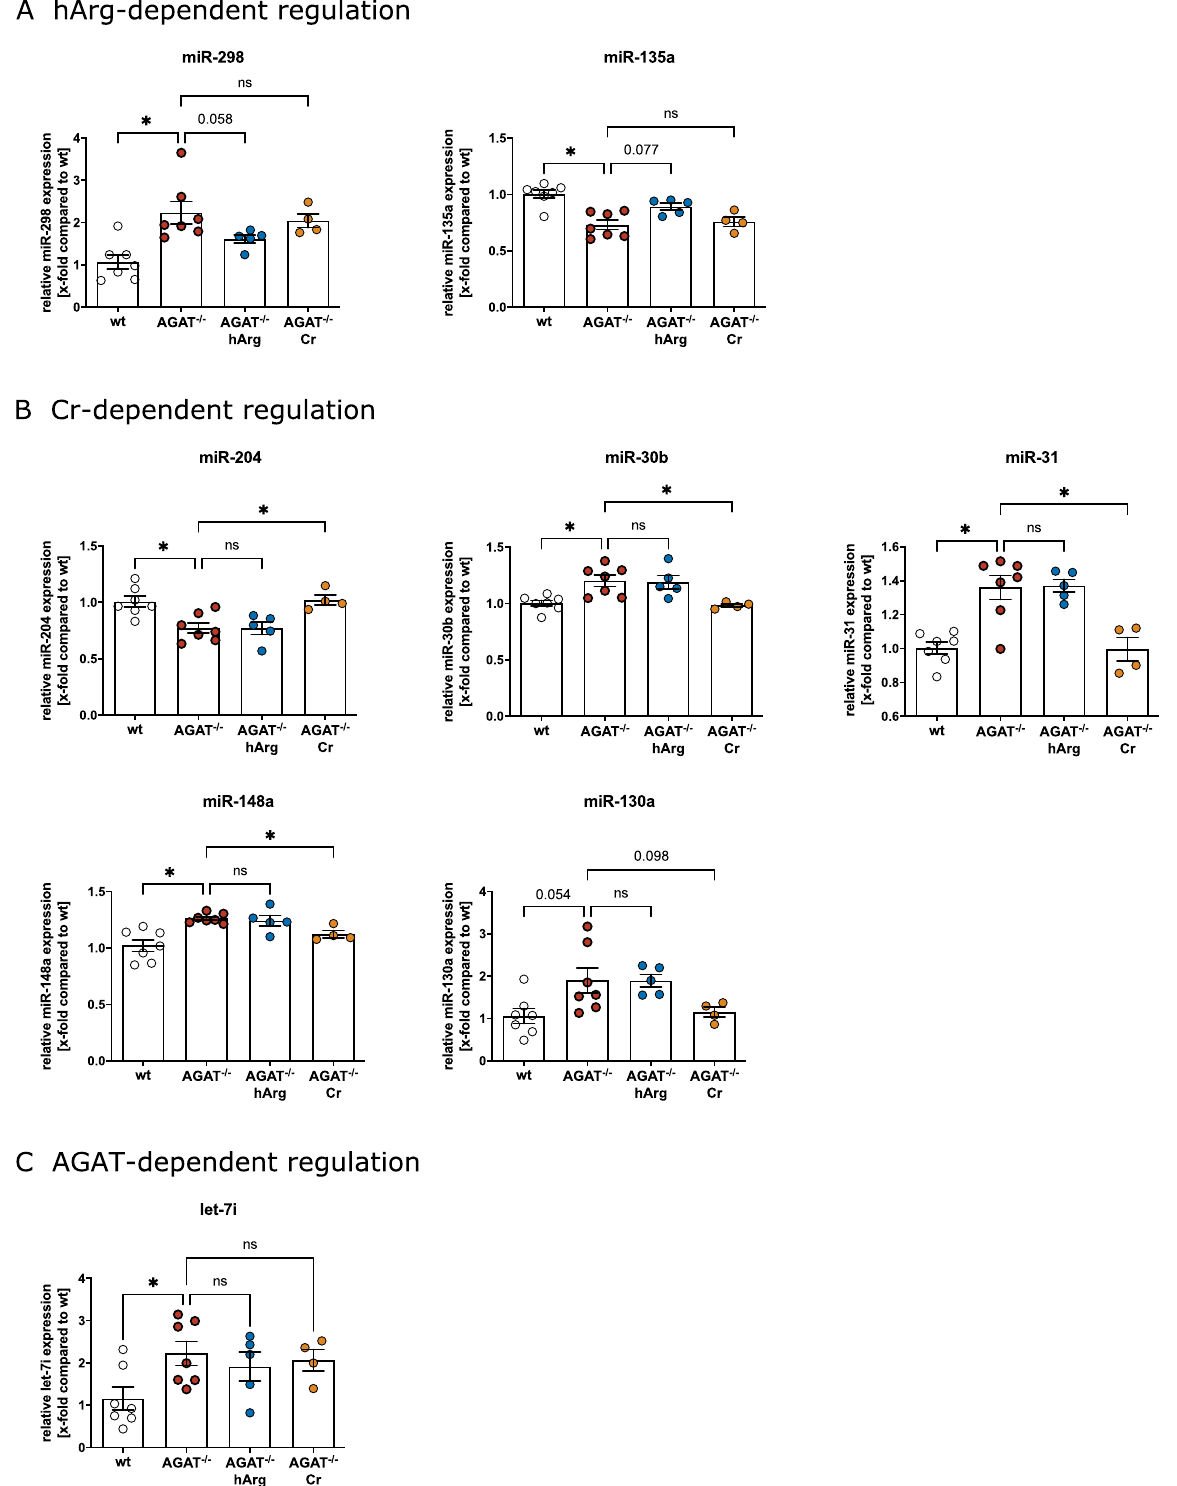
Figure 3. Analysis of candidate miRNAs in the heart by qPCR. Relative miRNA expression was measured in wild-type (wt; n = 7), AGAT knockout (AGAT -/- ; n = 7), homoarginine-supplemented AGAT -/- (AGAT -/- hArg; n = 5) and creatine-supplemented AGAT -/- (AGAT -/- Cr; n = 4) mice. Only miRNAs with positive validation are shown. Values are expressed as mean ± SEM. *P < 0.05 versus AGAT -/-